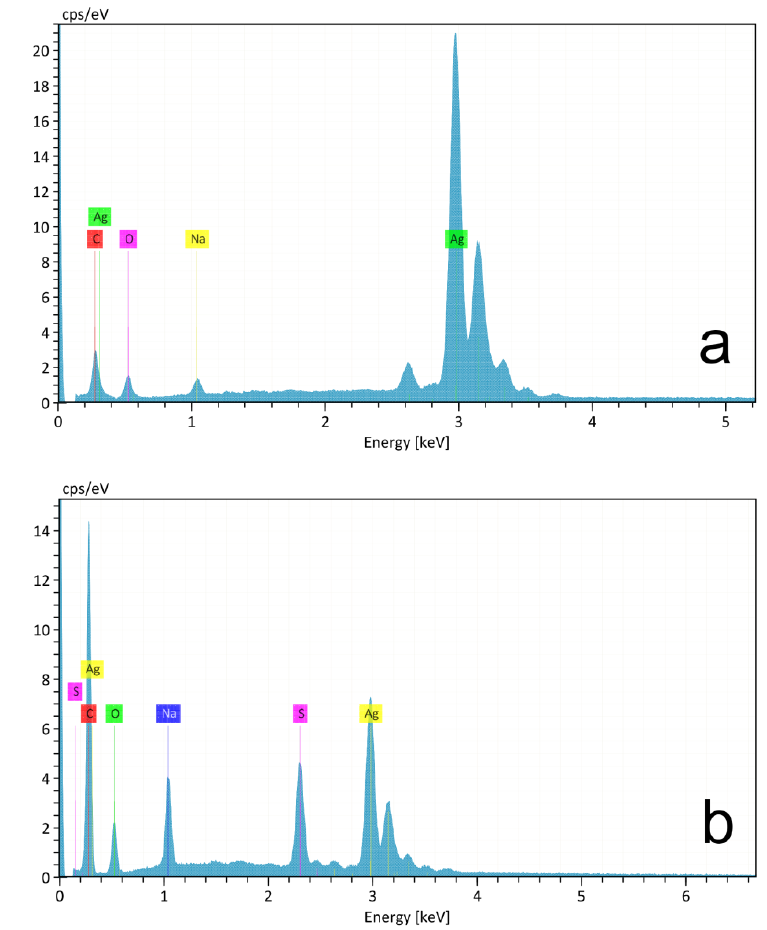
Figure 3. (a) EDX analysis of AgNPs and (b) AgNPs@11MUA